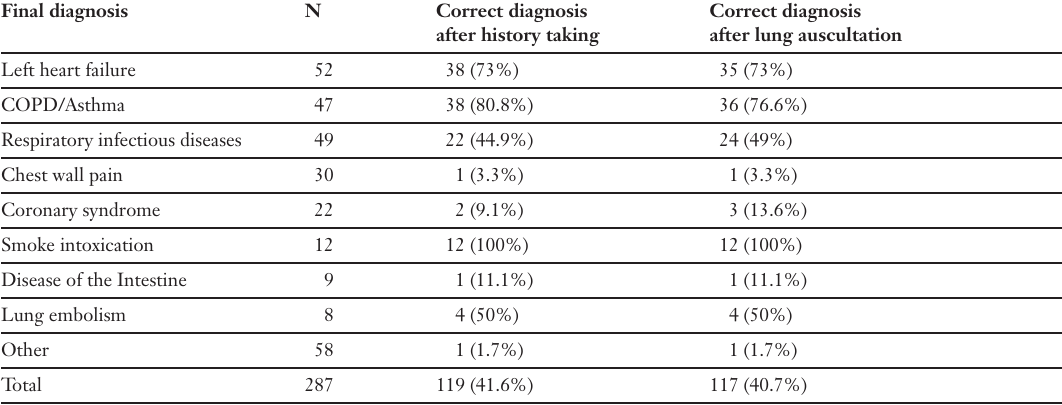
Estimated diagnosis after history taking in comparison with the final